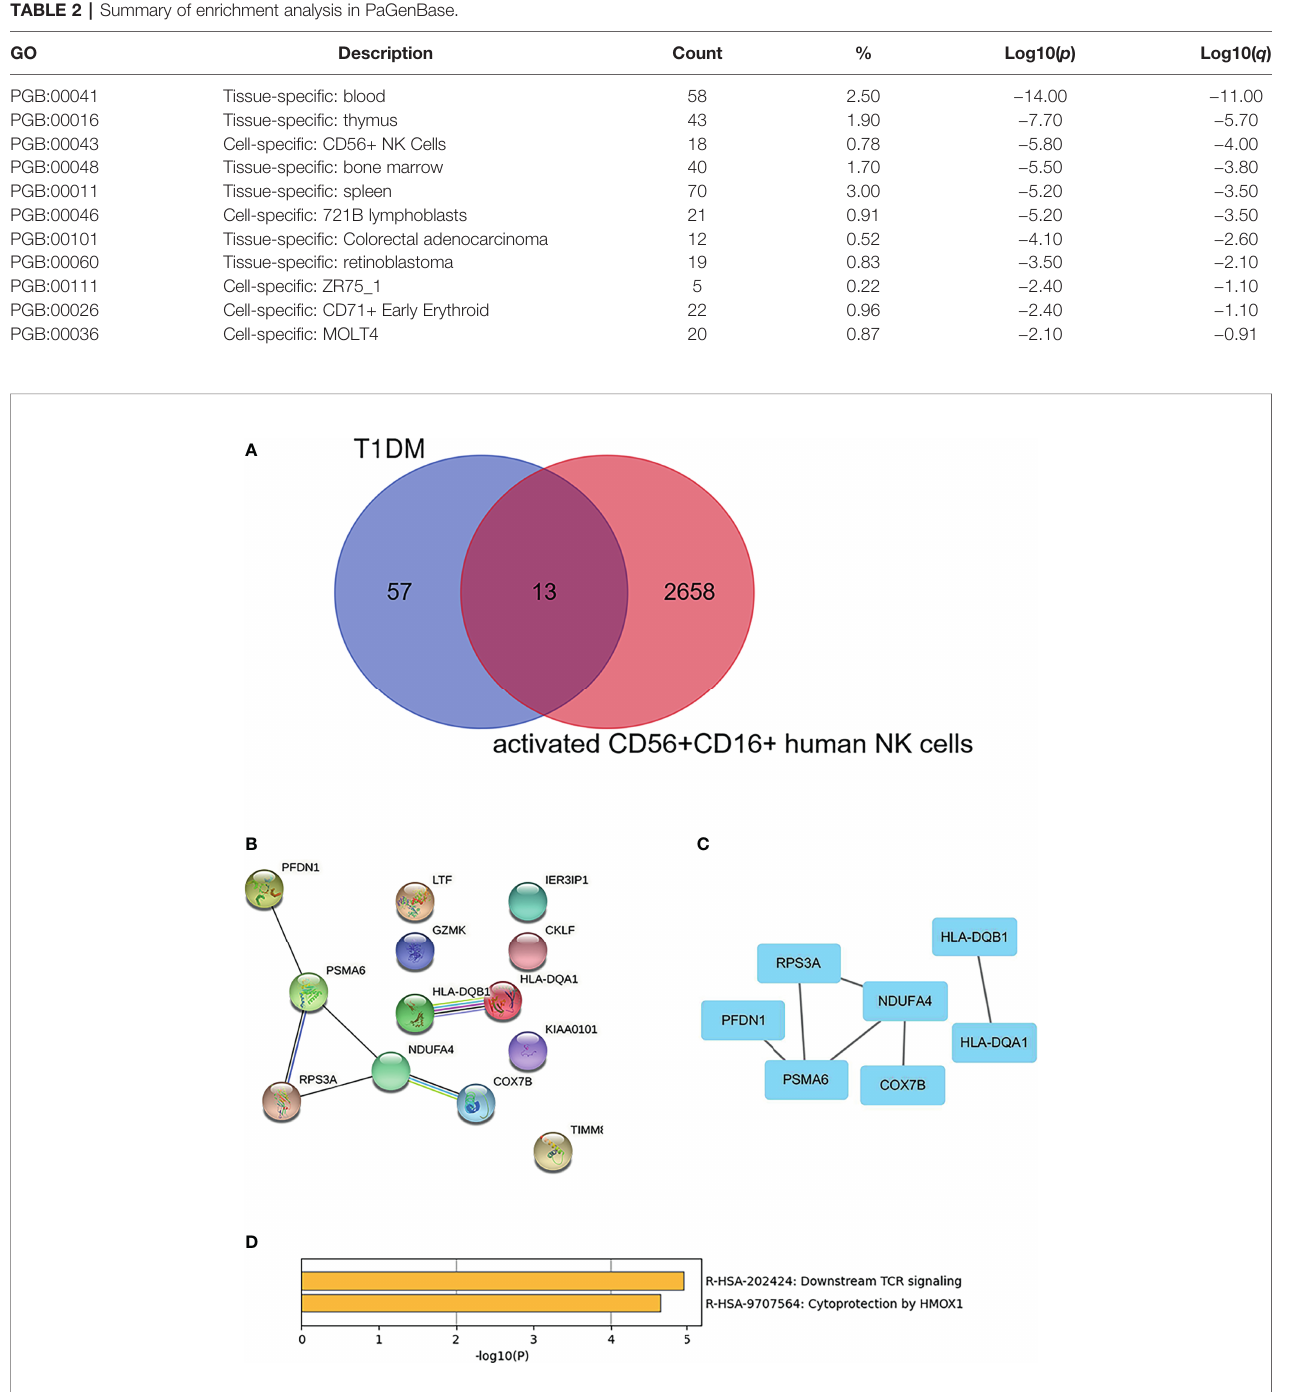
FIGURE 5 | Identi fi cation and cluster analysis of overlapping genes. (A) Venn diagram of differentially expressed genes between the DEGs in T1DM ketosis or ketoacidosis and DEGs in the activated CD56 + CD16 + human NK cell subset. (B) PPI network for the 13 overlapping genes. (C) Analysis of hub genes using cytoHubba for the overlapped genes. (D) Heatmap of Kyoto Encyclopedia of Genes and Genomes (KEGG) enriched clusters colored by p